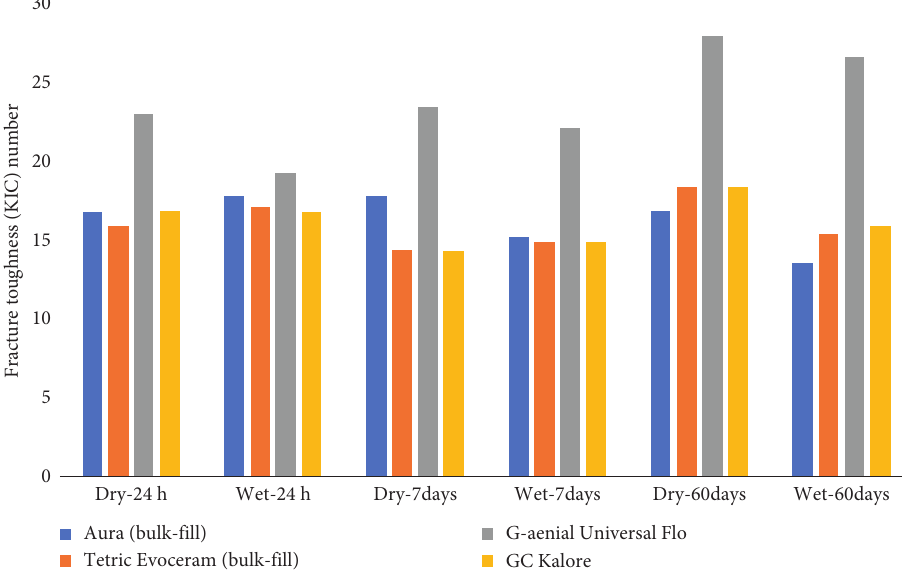
Figure 3: Mean values for sorption/solubility of all materials. Table 5: Mean ( ± SD) colour change values of different materials kept dry and wet in all time intervals.